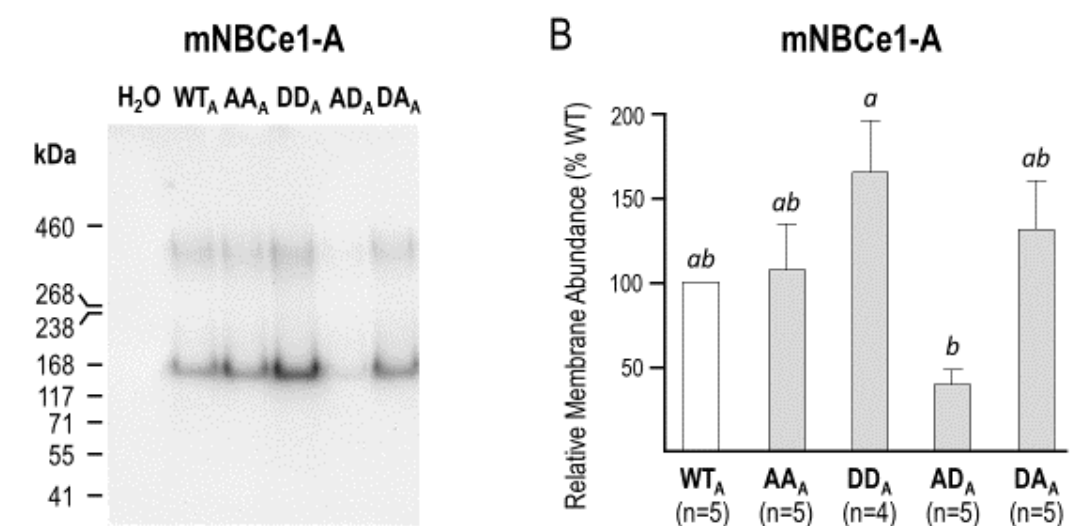
Figure 6. The relative membrane abundance of (de)phosphomimetic NBCe1-A clones in Xenopus oocytes. ( A ) Western blot showing EGFP immunoreactivity in biotinylated protein fractions (i.e., cell-surface-expressed) NBCe1-A-EGFP from Xenopus oocytes; ( B ) Quantification of the relative plasma-membrane expression of (de)phosphomimetic mutants of NBCe1-A, as compared to wild-type. Letters above bars indicate statistically indistinguishable groups (i.e., groups with different letter were significantly different from each other).